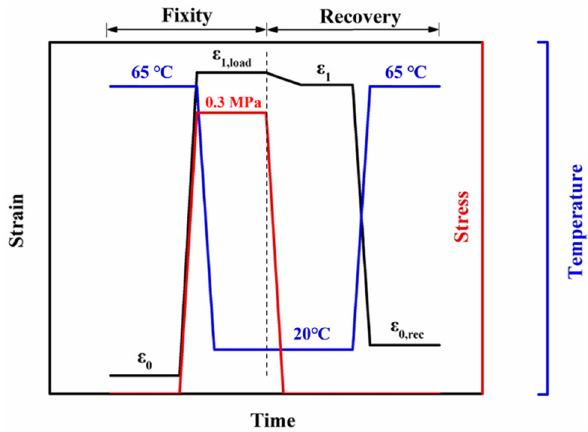
Figure 1. The procedure of the thermo-responsive shape memory test.